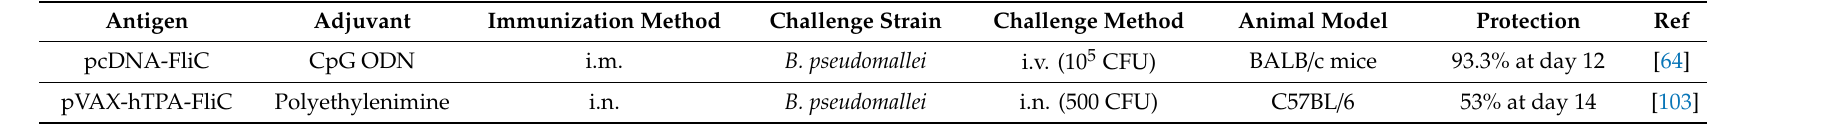
Table 5. DNA vaccines a .